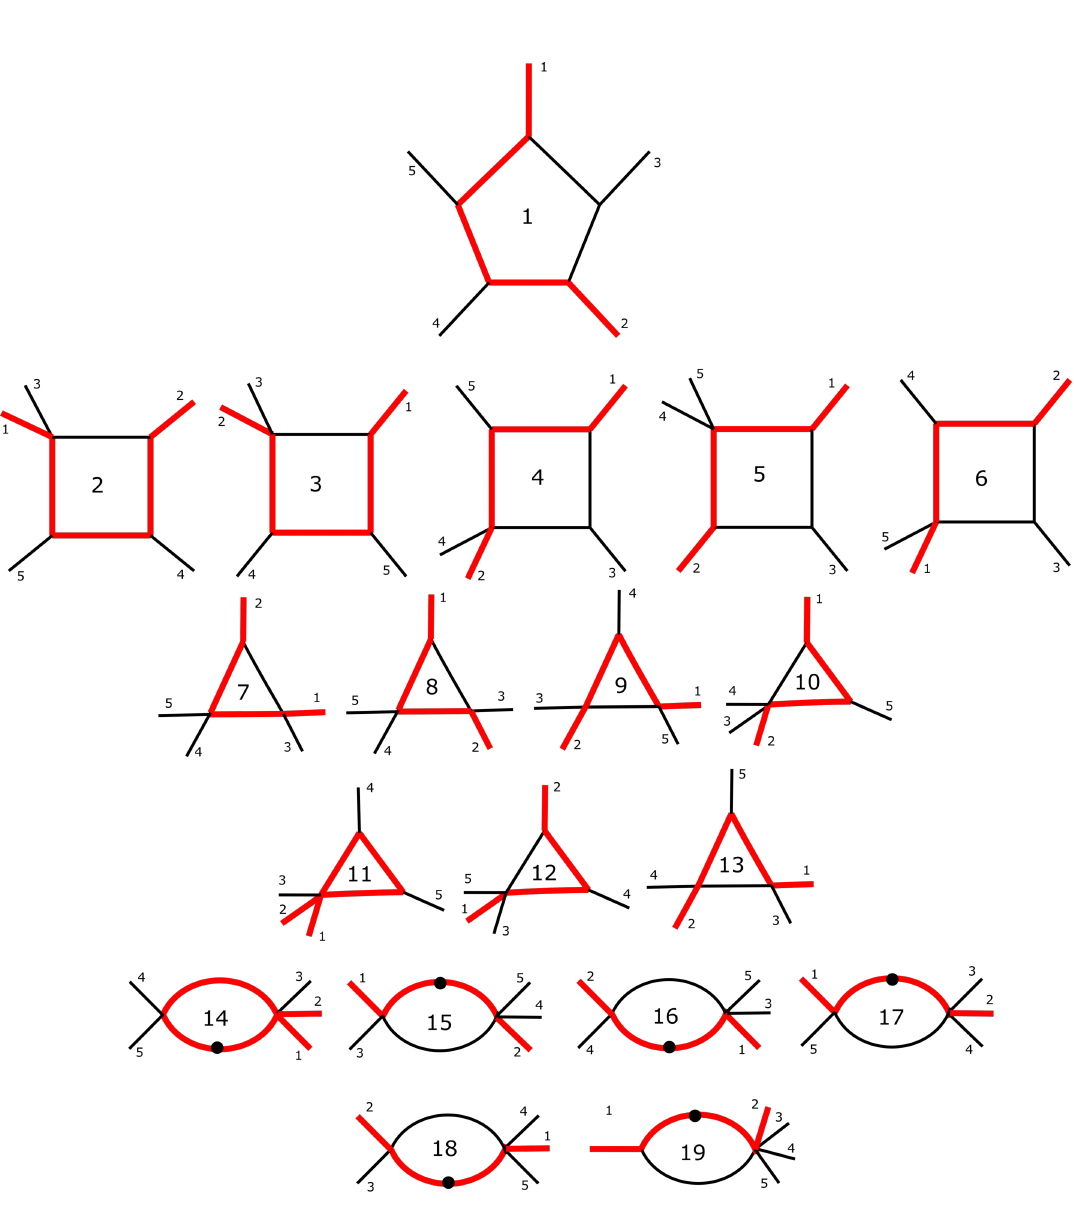
Figure 6 . The 19 master integrals appearing in topology T 4 , denoted by I ’s in (4.23). Red/black lines indicate massive/massless particles respectively. Dotted internal lines indicate propagators with an additional power in the denominator of the integral. Each integral is associated with a kinematic normalisation which ensures the basis leads to a canonical form differential